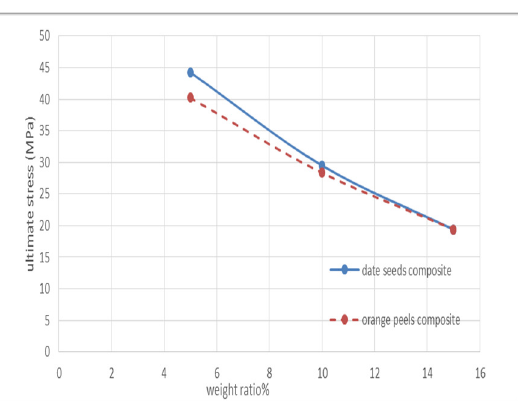
Fig. 4. Speciemens before and after tensile test.